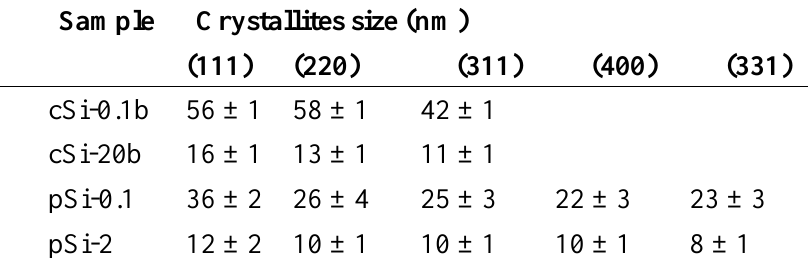
Table 2. Crystallites size obtained by means of Scherrer equation.